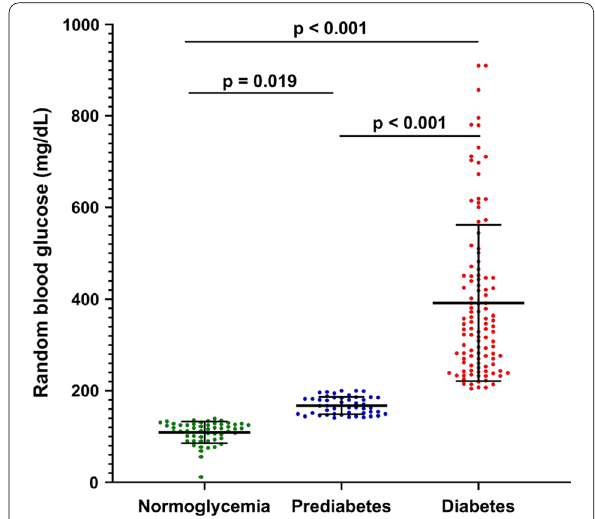
Fig. 1 Scatter dot plot of random blood glucose in COVID‑19 patients with normoglycemia (109.1 (167.6 19.0 mg/dL) or diabetes (391.6 ± standard deviations are indicated by horizontal and vertical lines